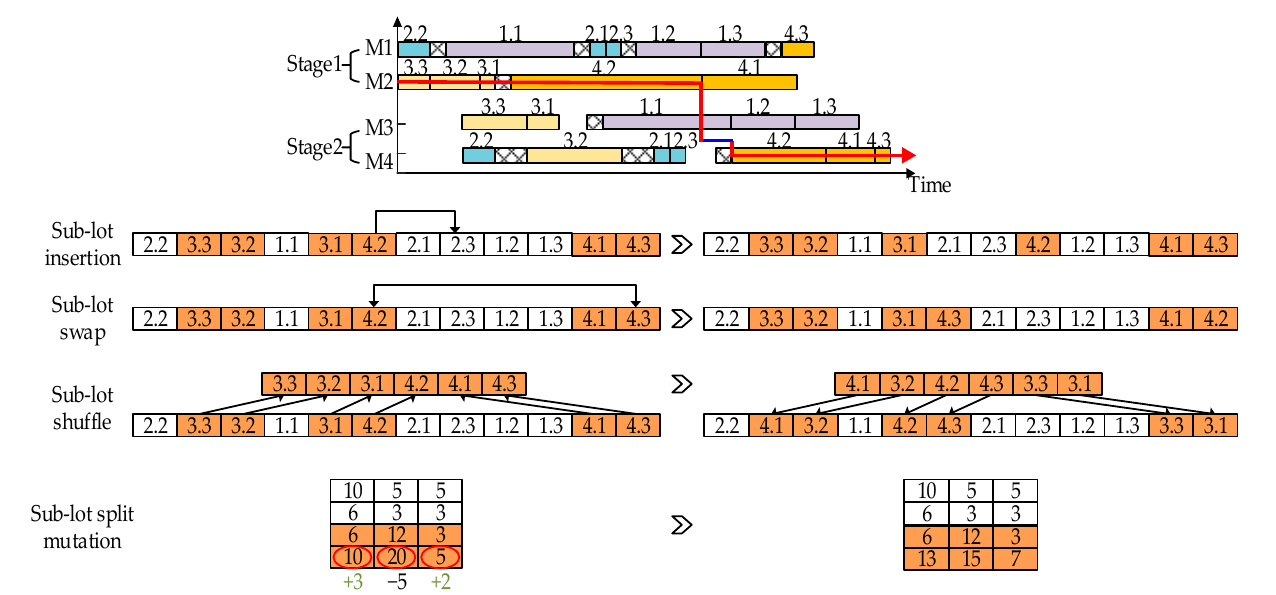
Figure 3. The illustrations of the neighborhood